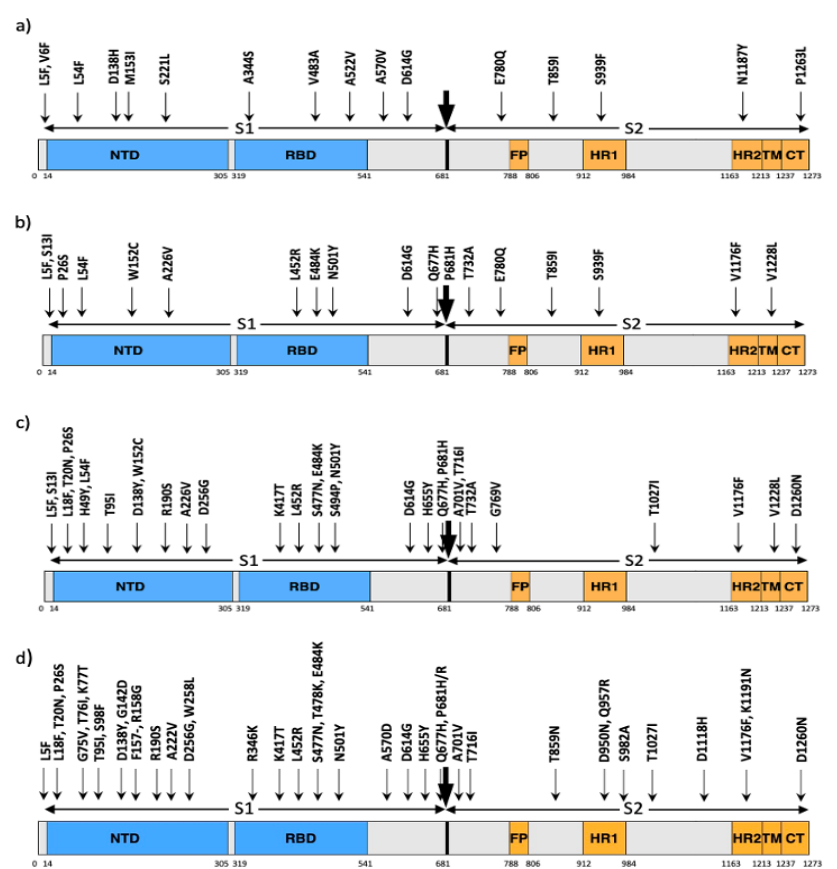
Figure 1. Notable mutations in the S protein of SARS-CoV-2. The arrows show where the mutations took place. ( a ) Mutations that were persistent over T1, T2 and T3. ( b ) Mutations that occurred in a significant number of isolates in T4 and T5. ( c ) Mutations that occurred in a significant number of isolates in T6, T7 and T8. ( d ) Mutations that occurred in a significant number of isolates in T9, T10 and T11.